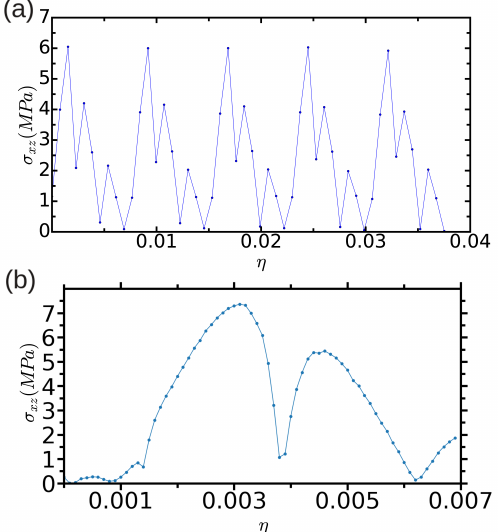
Figure 7. Evolution of the shear stress expressed as a function of strain for a simulation cell containing n = 344,544 atoms in which the thickness of the “U” region is taken to be d U = 5 c . Results obtained with ∆ η = 8 × 10 − 4 and 1 × 10 − 4 are shown in ( a , b ), respectively (see